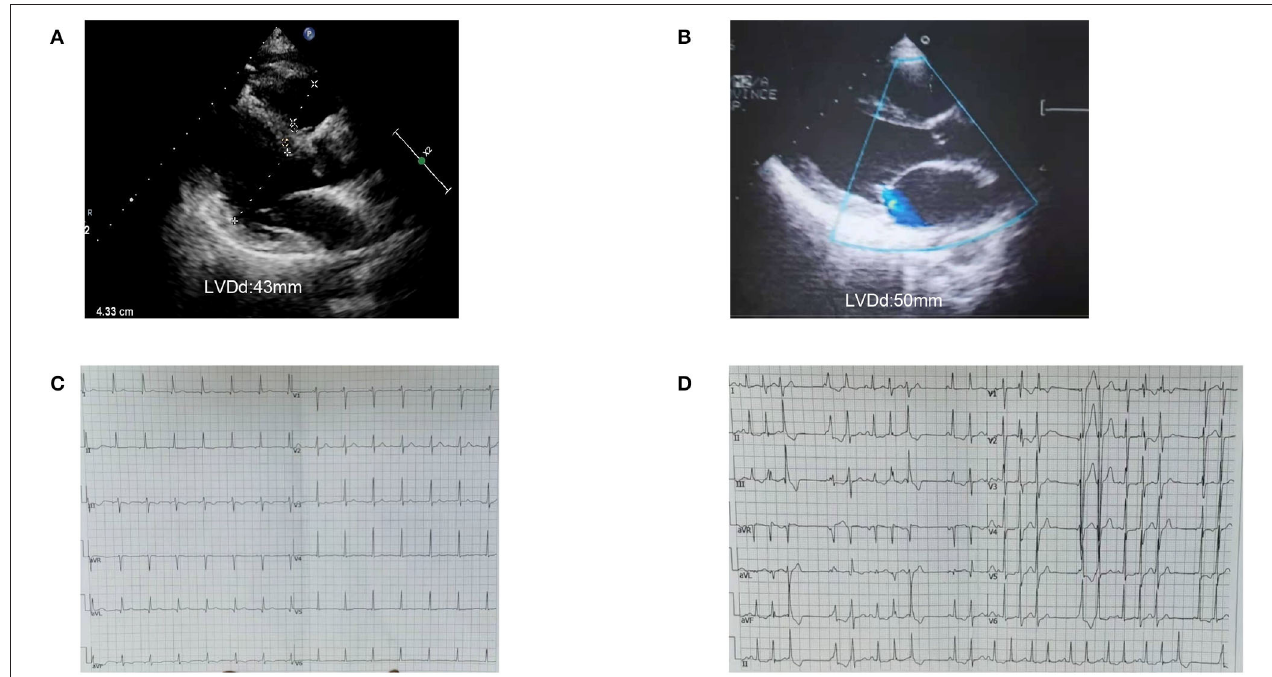
FIGURE 6 | Image of case 4 (II-4) and 5 (III-4). (A,B) Case 4 and Case 5 presented a normal left ventricle on echocardiogram. (C) ECG of case 4 (II-4) showed atrial rhythm, PR was shorter than 0.12s. (D) ECG of case 5 (III-4) showed frequent ventricular premature contractions with narrow QRS.